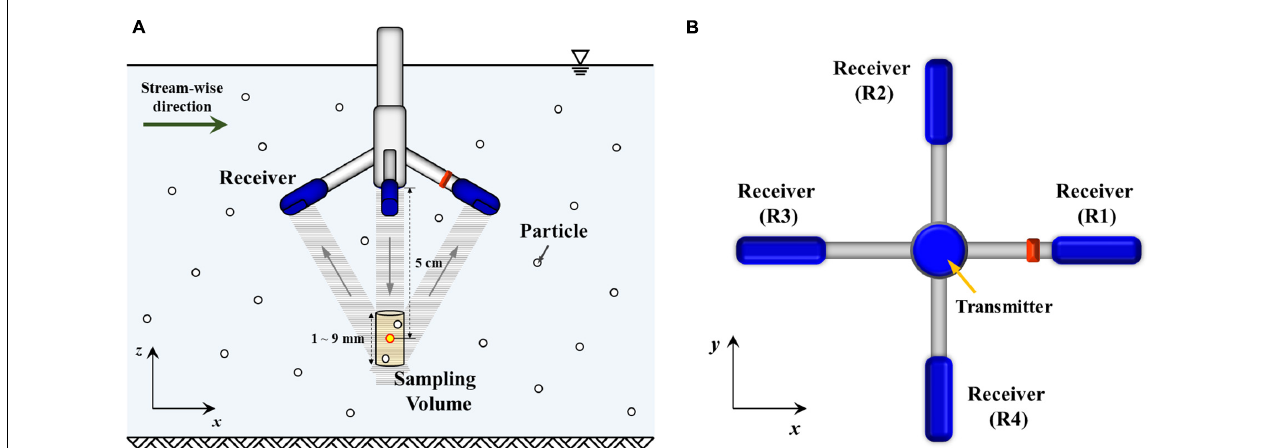
FIGURE 1 | Schematic diagram of ADV system: (A) Side view; (B) top view.